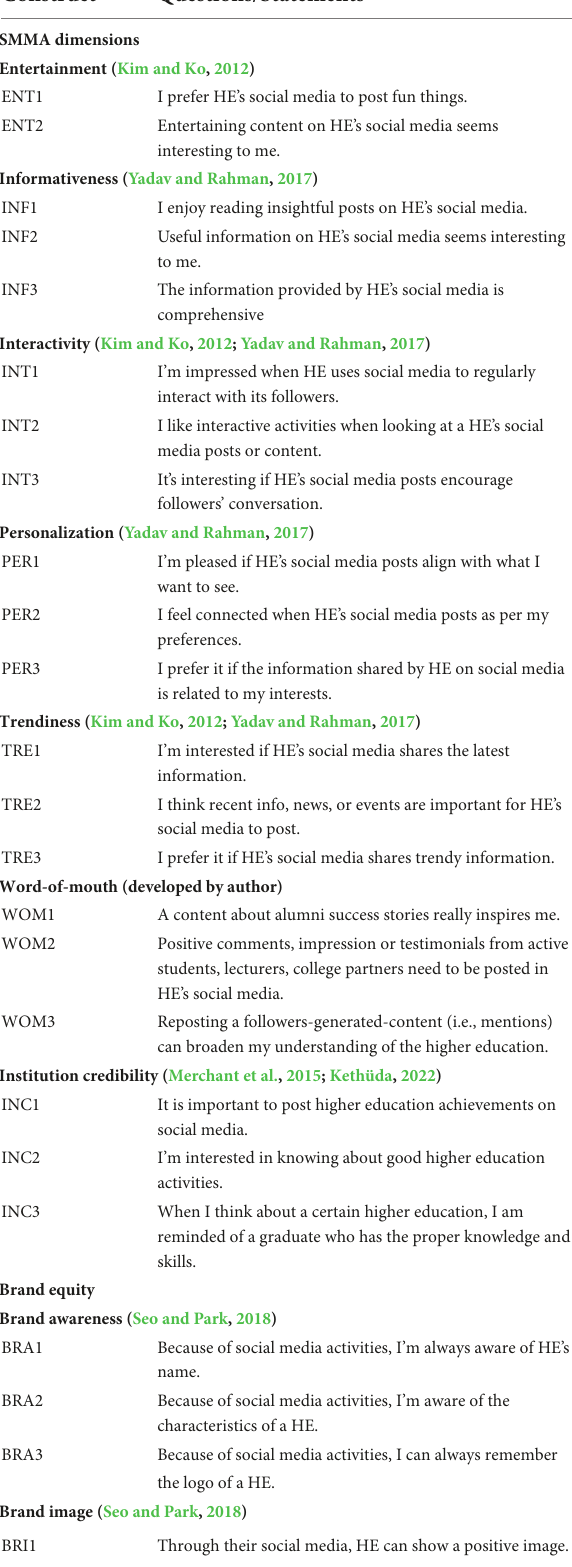
TABLE 4 Final measurement